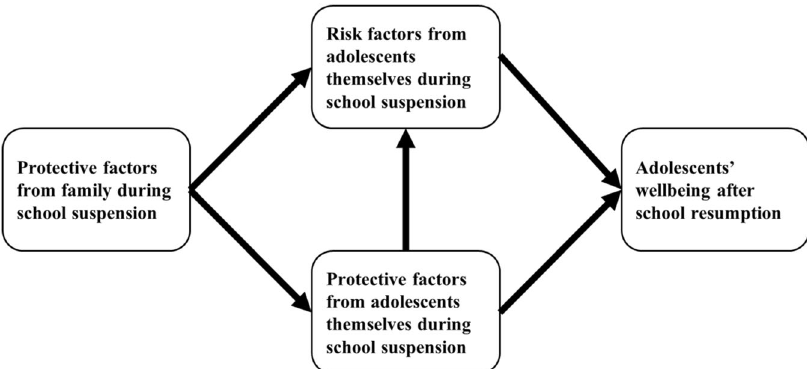
Fig. 1 Conceptual framework of protective and risk factors during school suspension for adolescents' well-being after school resumption. Protective factors from family during school suspension were supposed to be associated with both risk and protective factors from adolescents themselves. Adolescents' protective factors were assumed to be associated with their risk factors. Both risk and protective factors were directly associated with adolescents' well being after school